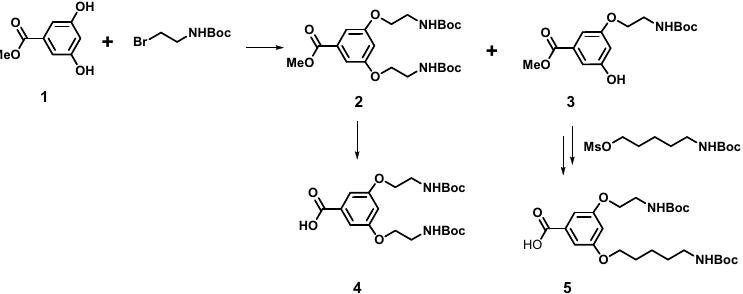
Scheme 1. Schematic representation for the synthetic pathway of branching units 4 and 5 (described in detail in [21]). Boc: tert